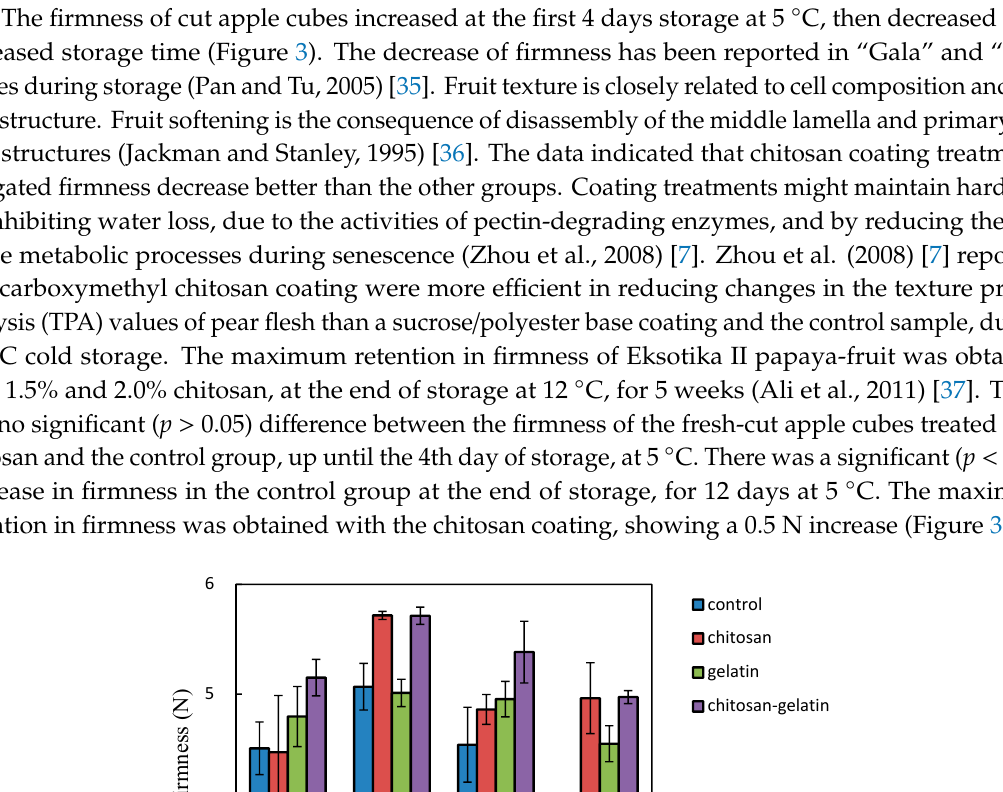
Table 3. pH changes of cut apple cubes coated with different coatings and stored at 5 °C and 22 °C for 12 days. pH